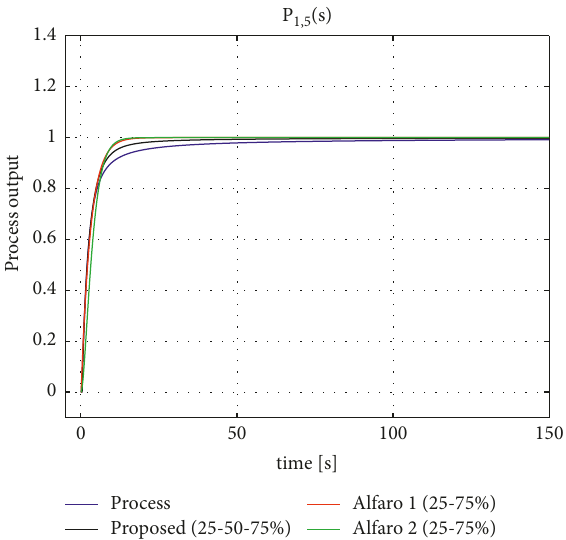
Figure 13: Process reaction curve and step responses for FFOPDT model method # 5 and FOPDT and DPPDT model methods # 7 and # 9, respectively.